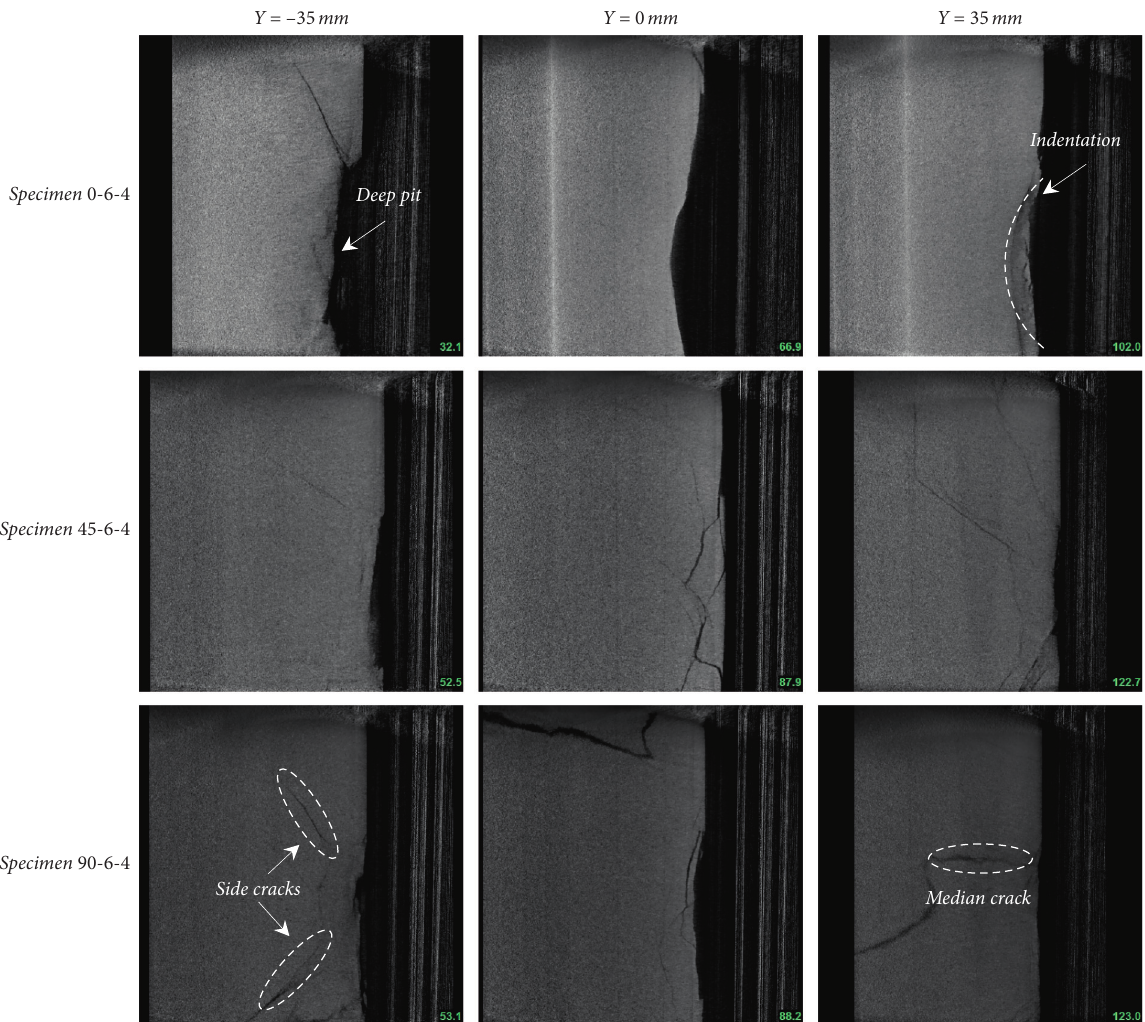
Figure 15: CT images in the Y plane for the α � 0 ° , 45 ° , and 90 ° specimens under a maximum principal stress of 6